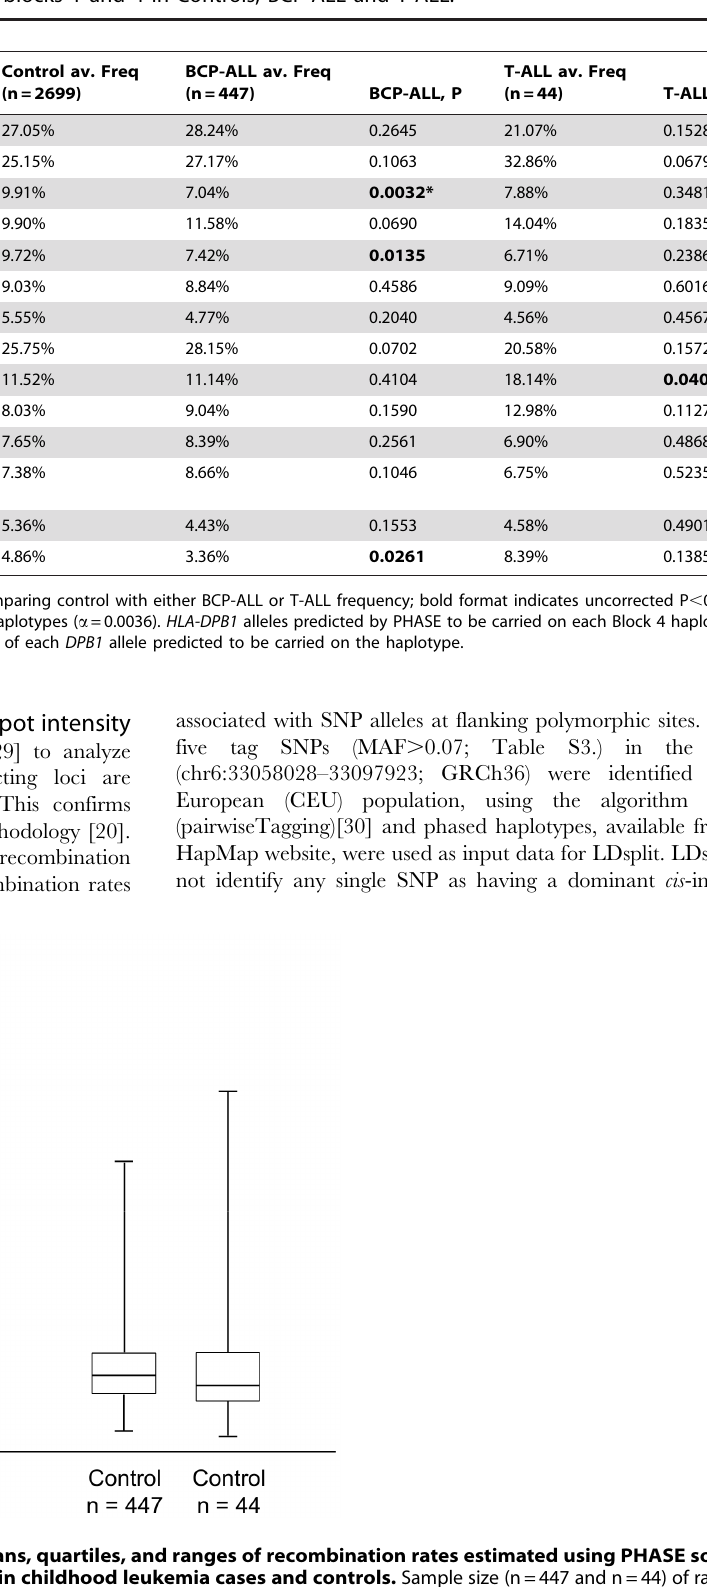
Table 2. Frequencies of specific haplotypes in blocks 1 and 4 in Controls, BCP-ALL and T-ALL.